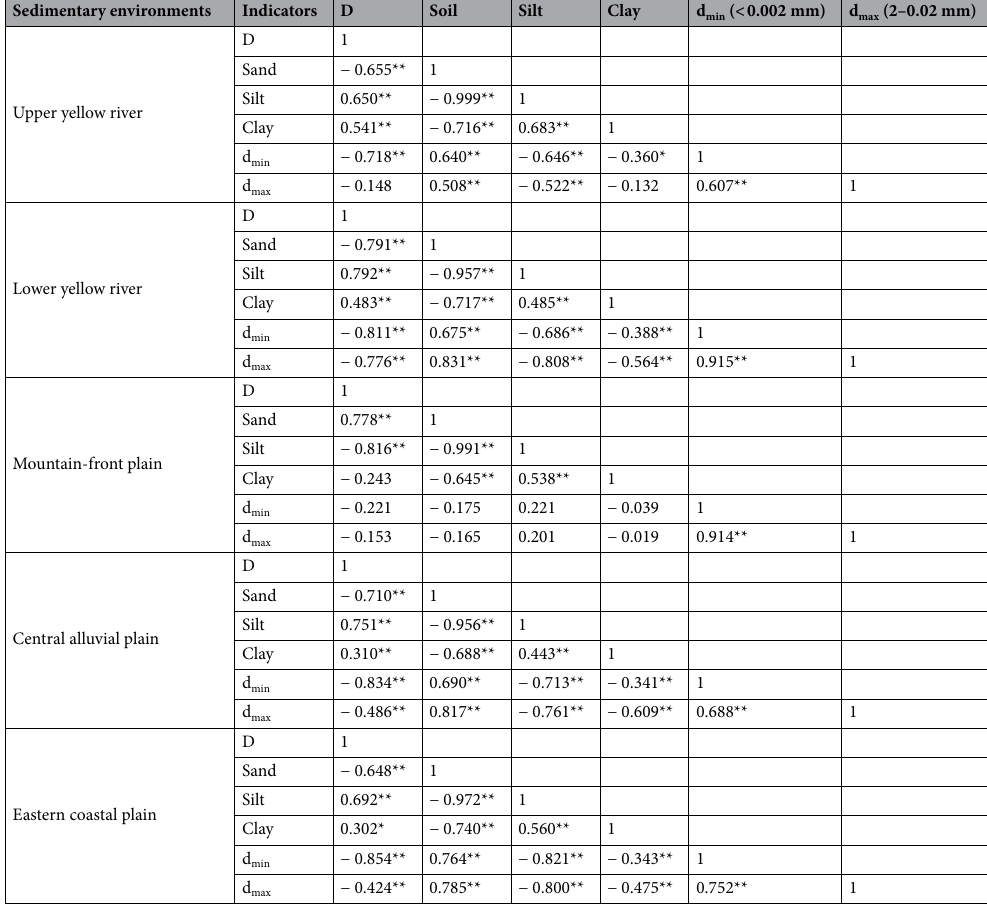
Table 4. Correlation of soil particle size characteristic parameters under different sedimentary environments.